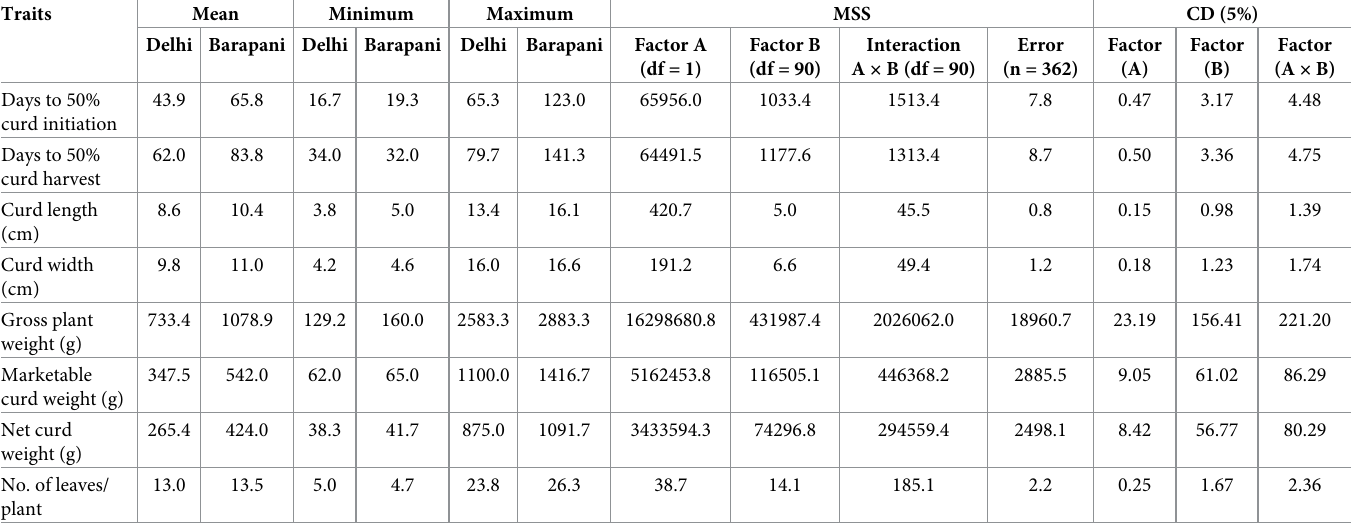
Table 1. ANOVA of agro-morphological traits of cauliflower at Delhi and Barapani centres. Traits